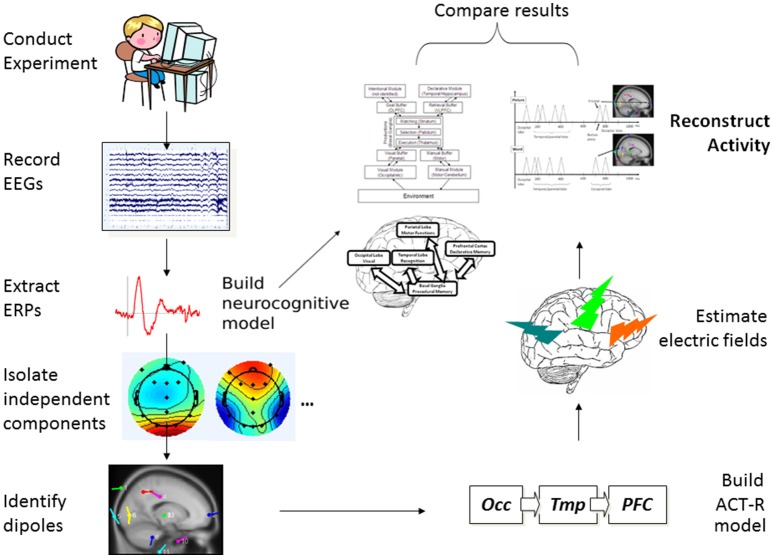
Process flow representation of the present study.